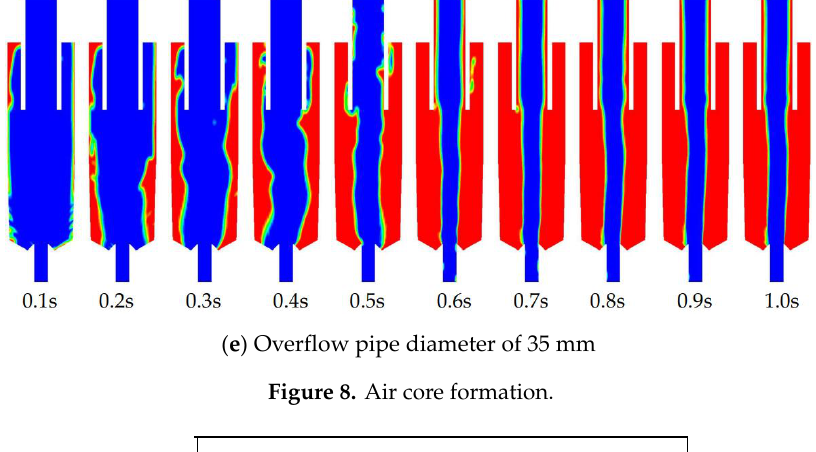
Figure 8. Air core formation.